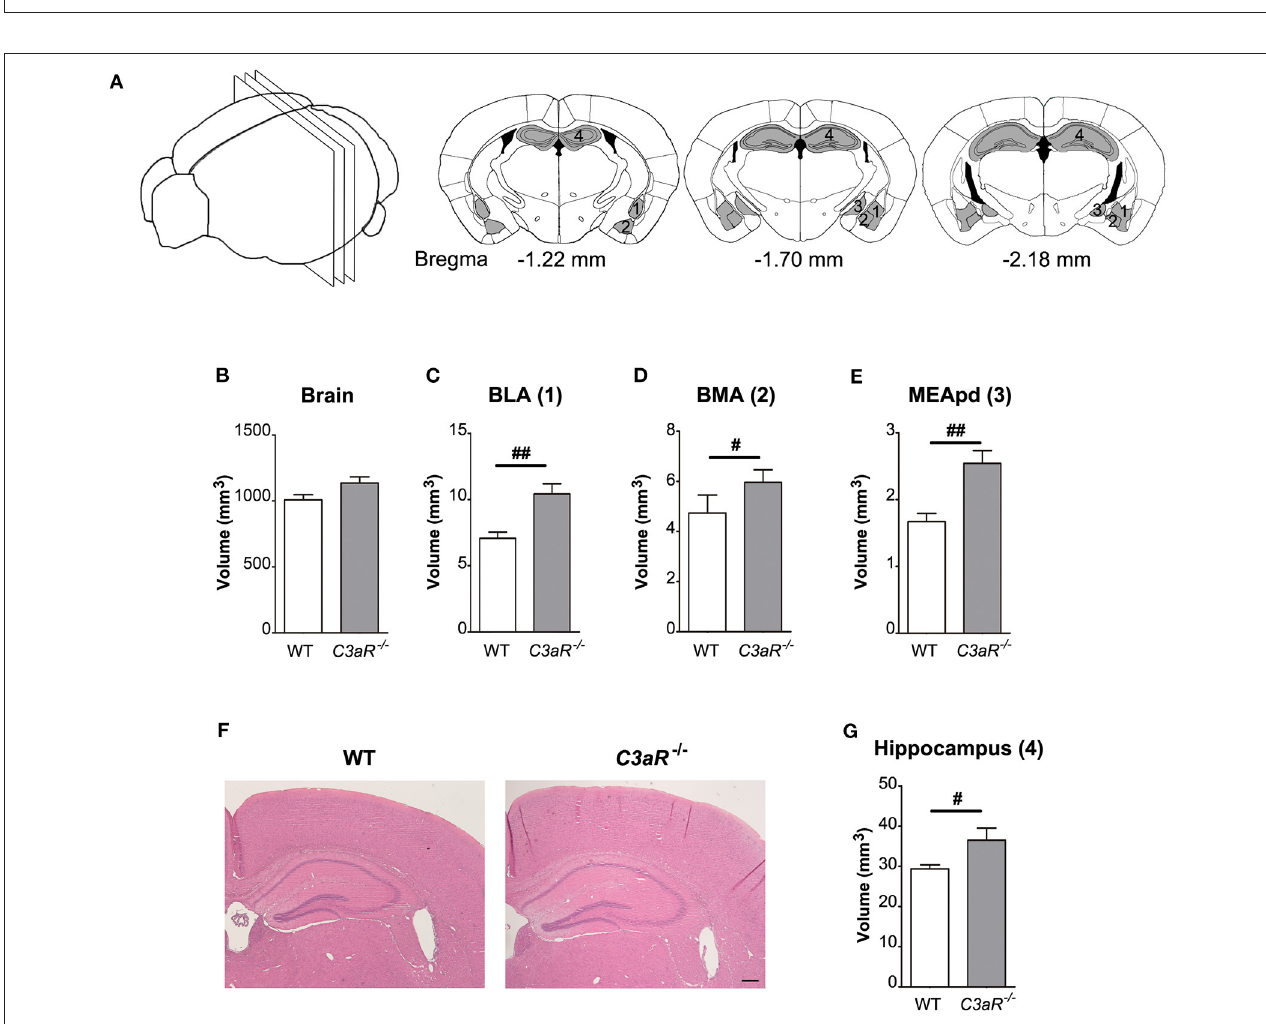
FIGURE 5 | C3aR − / − mice have larger amygdala and hippocampus but normal brain volume. Morphological assessment of the volume of the amygdala, the hippocampus, and the brain. (A) Schematic representation of the regions assessed and brain sections used for the quantification. Volume of (B) the whole brain between bregma − 1.22mm and − 2.18mm. (C) BLA, basolateral amygdalar nucleus; (D) BMA, basomedial amygdalar nucleus; (E) MEApd, medial amygdalar nucleus post-erodorsal; (G) hippocampus. (F) Representative images of hippocampus at bregma − 1.70mm; n = 11 per group; mean ± SEM. # p < 0.05 and ## p < 0.01. Two-tailed unpaired Student’s t -test. 1–4 in (A) indicate the location of the respective regions in (B–E) . Scale bar, 200 µ